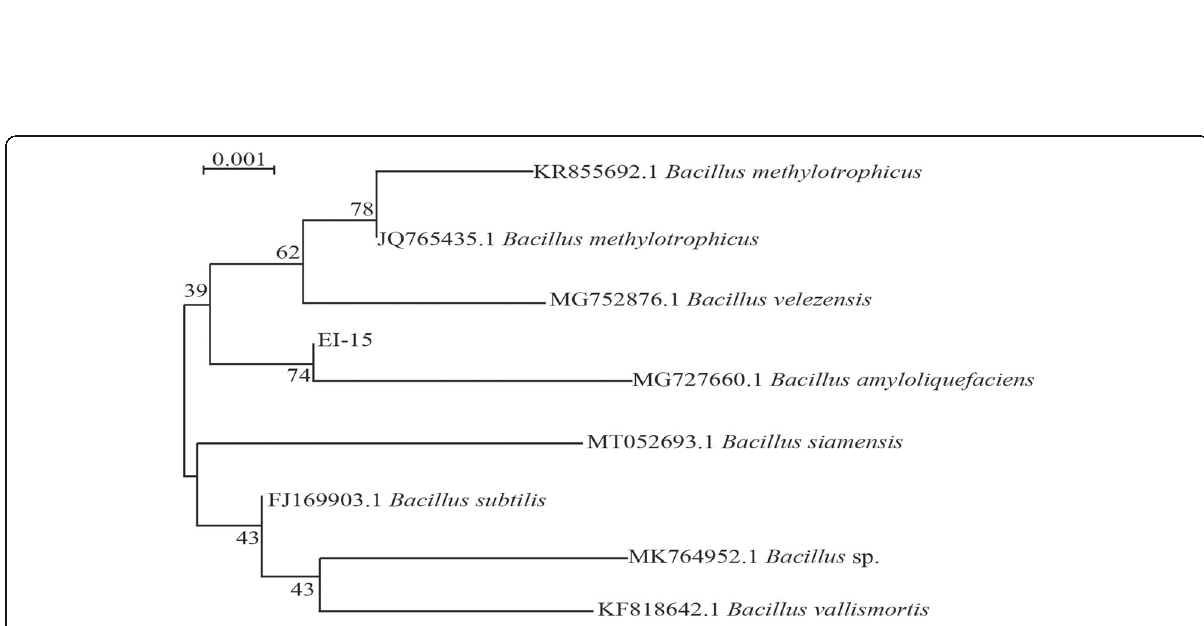
Fig. 1 Endophytic bacteria inhibited the mycelial growth of Alternaria alternata YZU. A A. alternata YZU growth alone. B The antagonistic effect of EI-15 against A. alternata YZU and C antagonistic activity of six endophyte isolates against A. alternata YZU. Values are means ± SD ( n = 10). Different letters above the bars indicate a significant difference at p < 0.05